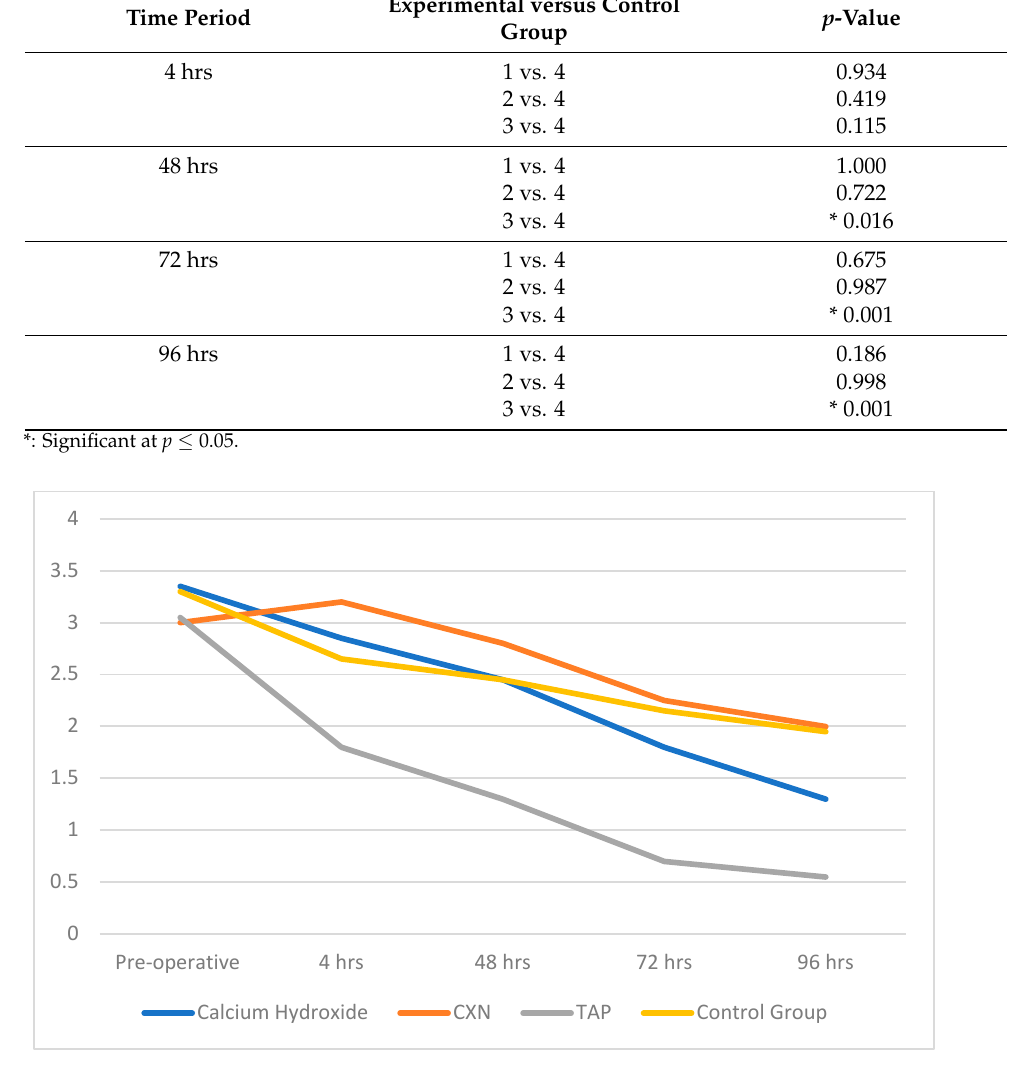
Figure 4. Line chart showing mean pain scores at different time intervals by treatment group.